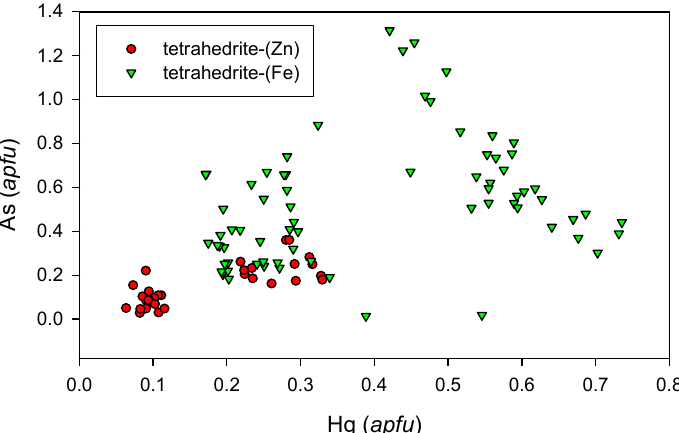
Figure 19. Chemical composition of the tetrahedrite group minerals in the graph Ag vs. Hg (apfu ).